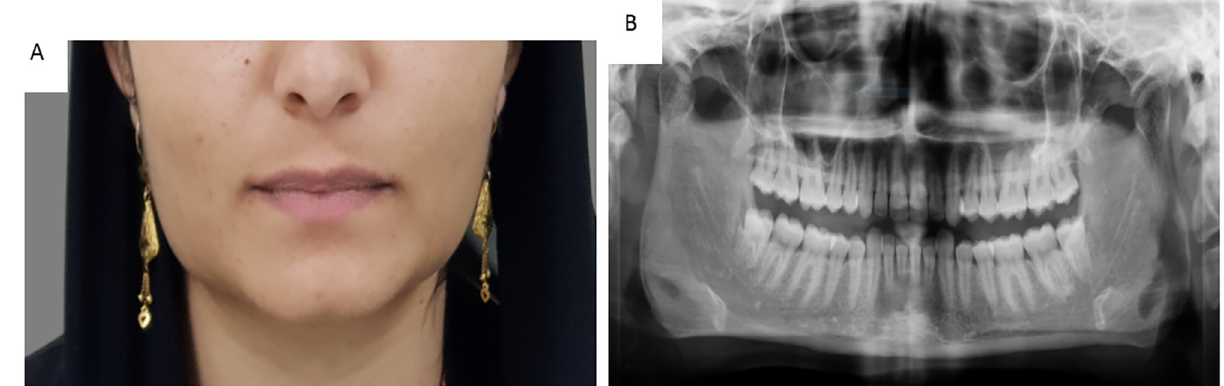
Fig. 2. Pre operation condition. A: Prominence of mandibular angle; B: Pre-operative OPG.